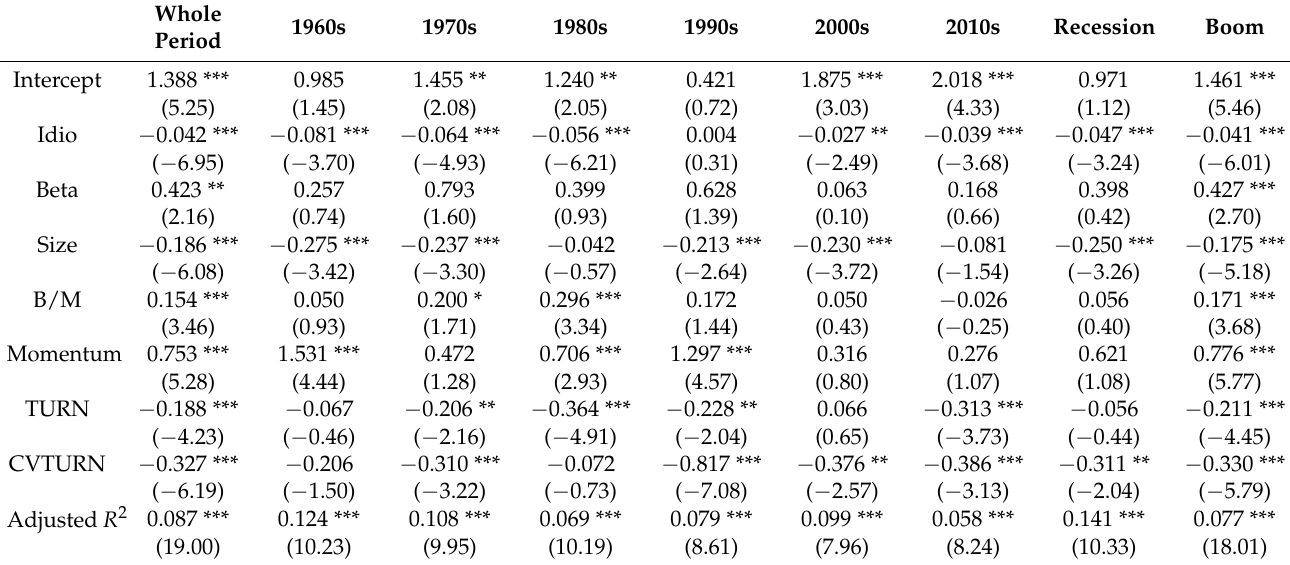
Table 5. Fama–Macbeth regression analysis. This table reports the results of the firm-level Fama and MacBeth (1973) regressions of monthly stock returns on idiosyncratic risk for the period of July 1963 to December 2019. A stock should have at least 15 daily returns in a month to be included in the risk estimation. Stock-level market beta is estimated from 60-month rollover regressions. Size and B/M are size and book-to-market ratio in Fama and French (1992). Momentum is the compound gross return from month (t − 7) to (t − 2). TURN and CVTURN are the average volume turnover and coefficient of variance of TURN calculated over the past 36 months in Chordia et al. (2001). The idiosyncratic risk (Idio) is the standard deviation of regression residuals of daily stock returns in month t − 1. The Newey–West adjusted t-value is reported in parentheses. To avoid the effect of possibly spurious outliers, all explanatory variables below 0.1 (above 99.9) percentile are set equal to 0.1 (99.9) percentile. *, ** and *** denote the statistical significance level at 10%, 5% and 1%,